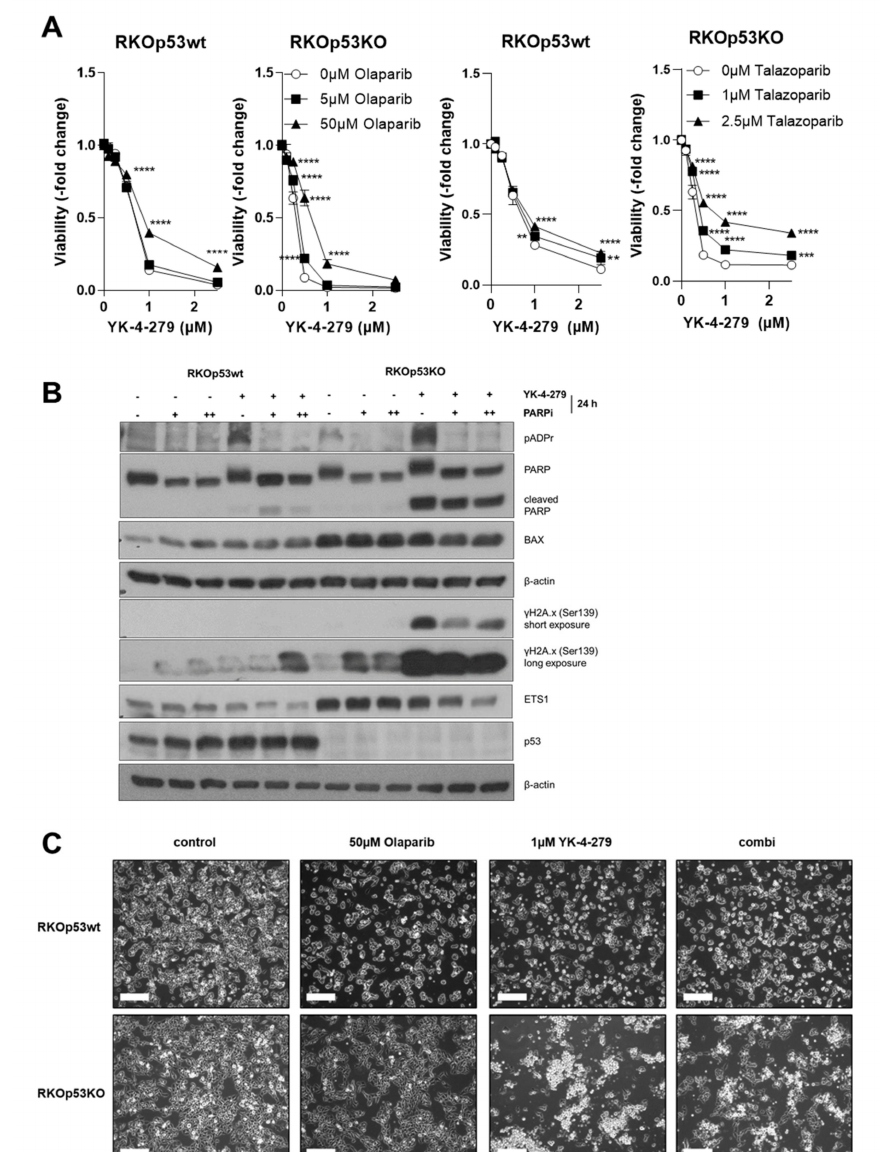
Figure 5. PARP inhibition protects against YK-4-279-induced cell death. ( A ) E ff ect of PARP inhibitors (olaparib, left panels; talazoparib, right panels) in combination with YK-4-279 for 72 h on viability of RKO subclones was determined by MTT-based cell viability assay. Results are given normalized to untreated controls as means ± SD of one representative out of three experiments performed in triplicate. Statistical analysis was conducted using two-way ANOVA with Bonferroni post-test. ( B ) Changes in PARylation of PARP1 upon 24-h YK-4-279 exposure ( + , 1 µ M) without or with olaparib ( + , 5 µ M; ++